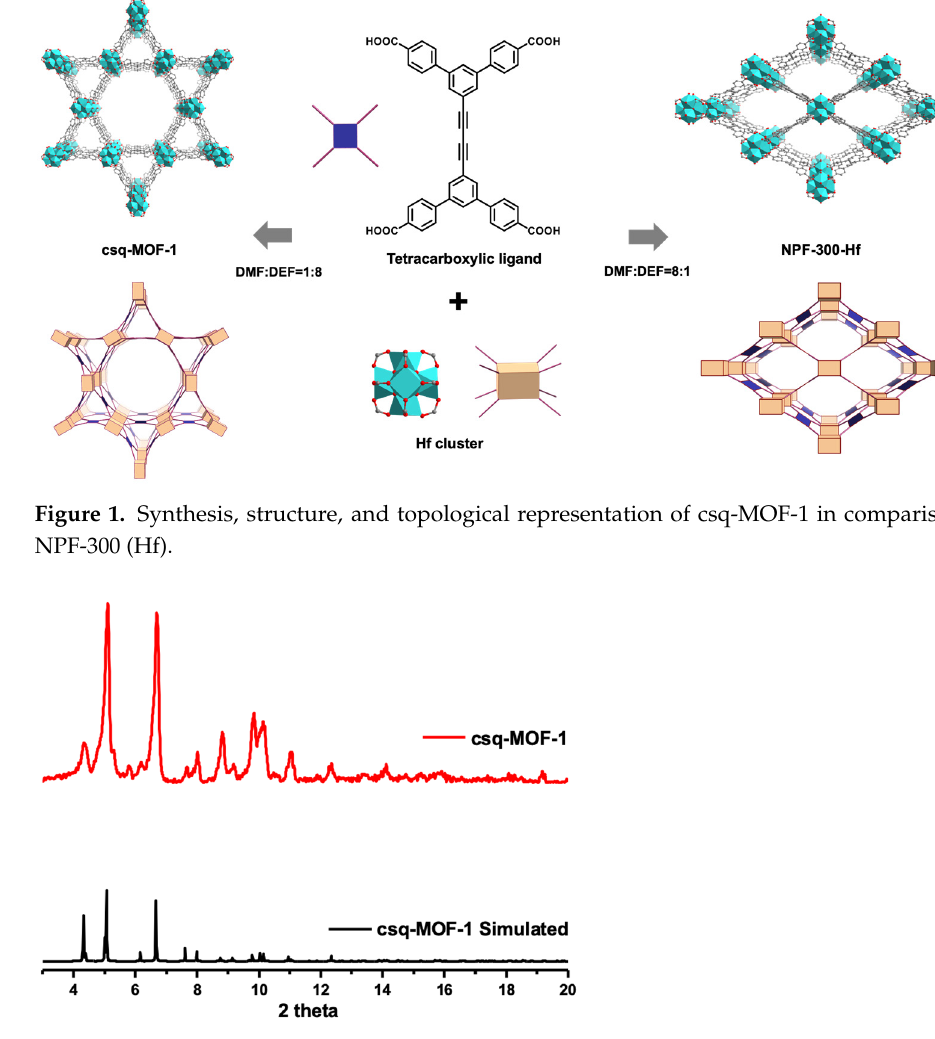
Figure 2. PXRD of csq-MOF-1 in comparison with simulated patterns from a single-crystal